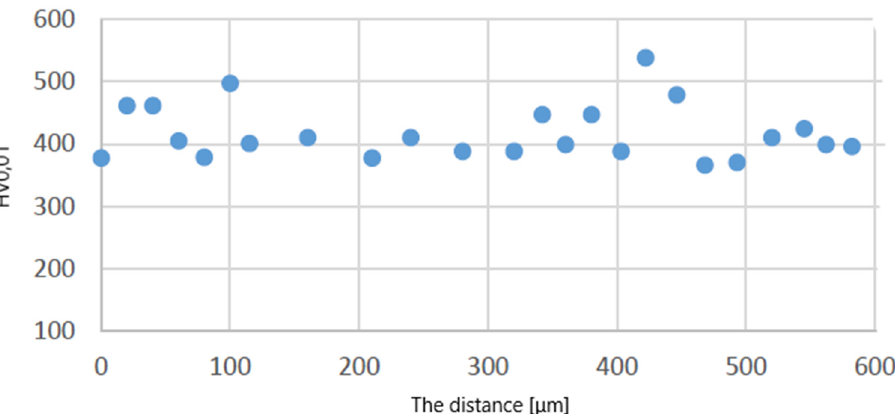
Figure 11. Distribution of microhardness on the leading edge for the protective coating made using the APS + VPA method.